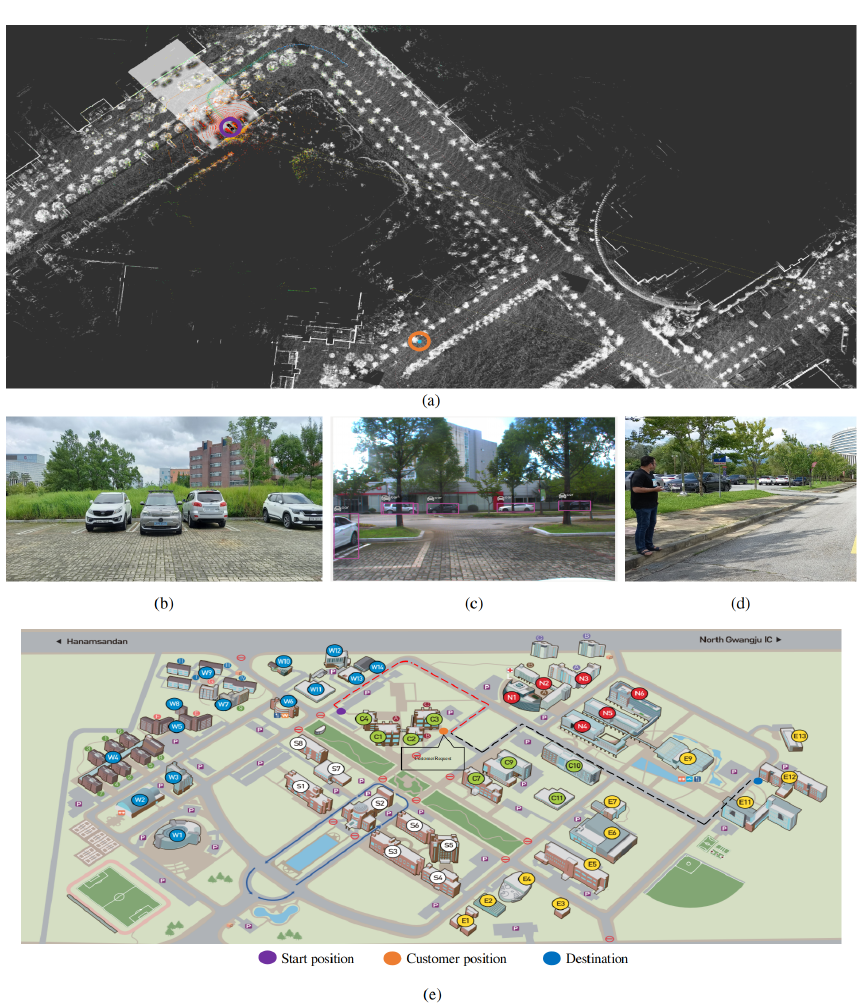
Figure 24. The visualization of autonomous taxi service as an application of our autonomous vehicle. ( a ) The 3D map shows the start and customer’s pick up position upon receiving the request. ( b ) Image view of start position. ( c ) Front-facing camera view from the start position. ( d ) illustrates that the customer is waiting for the autonomous taxi service. ( e ) The map of our institute shows the start, customer and destination position (Best viewed in color).